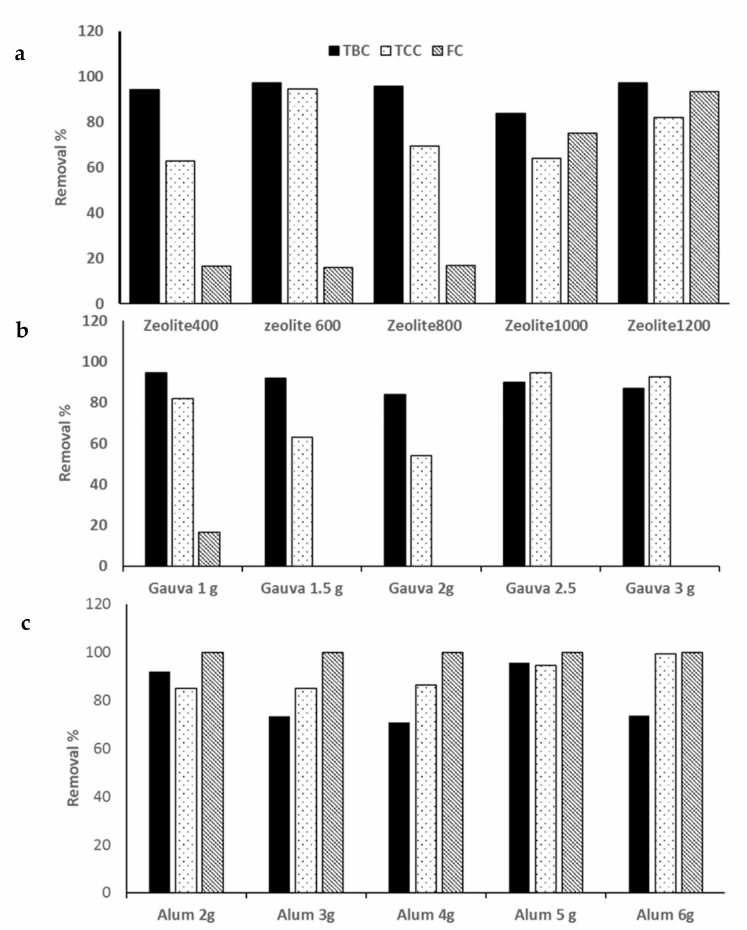
Figure 5. Microbiological contaminant removal efficiencies from wastewater by coagulation processes using ( a )zeolite, ( b ) guava-leaf powder (GLP), and ( c ) Alum. Total bacterial count (TBC), total coliform count (TCC), fecal coliform